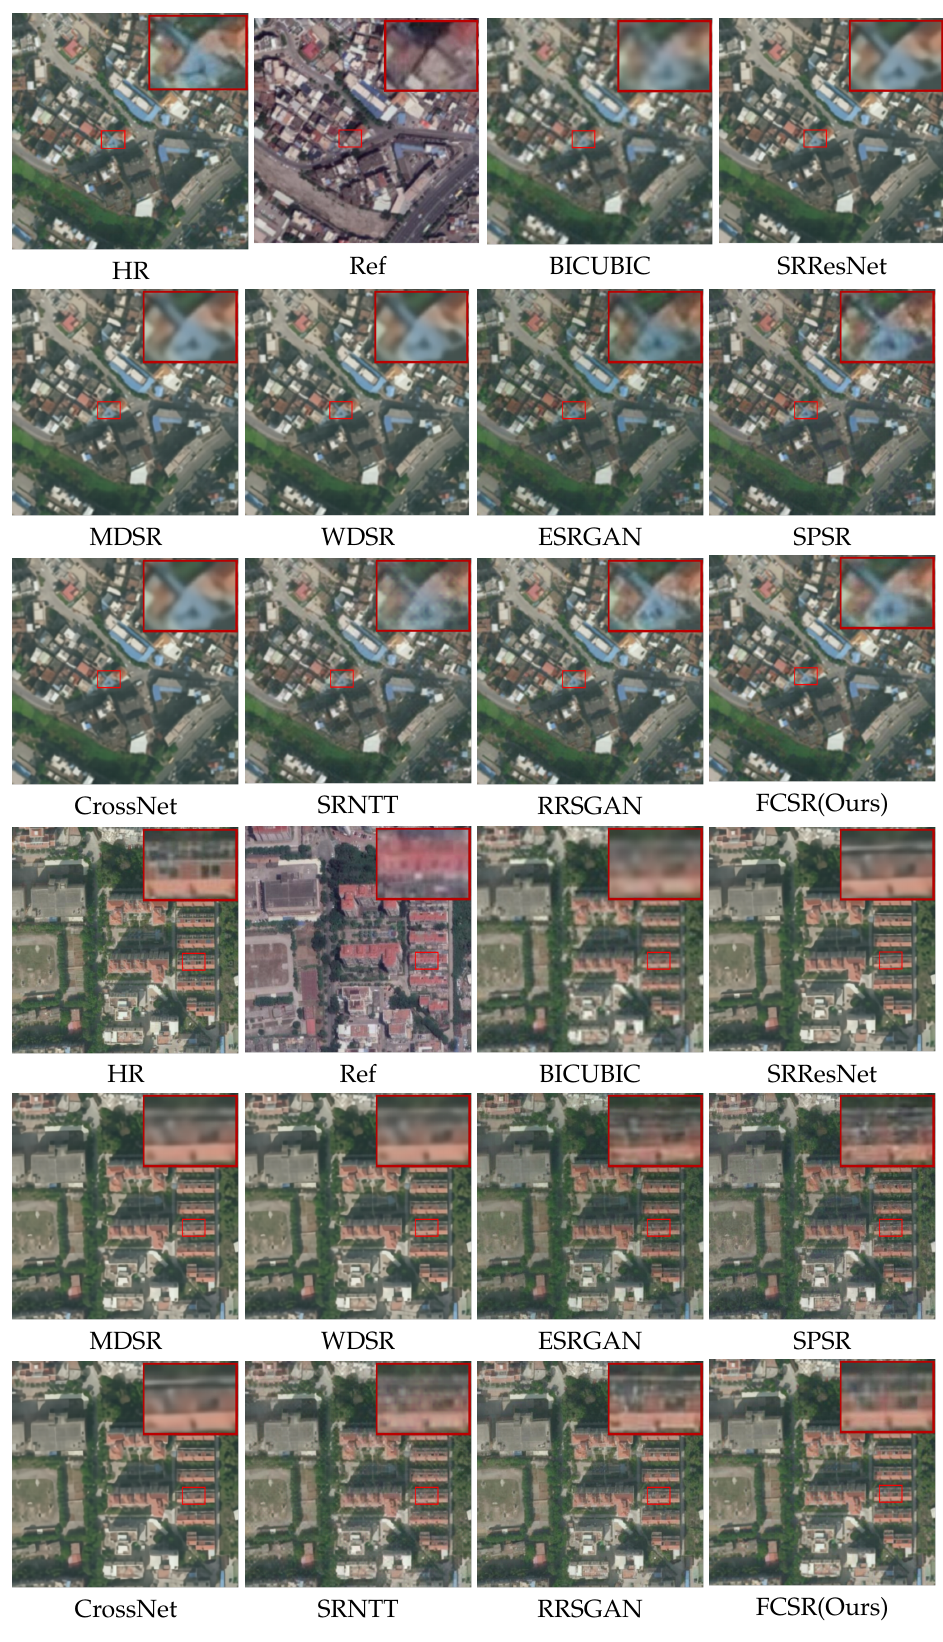
Figure 5. Visual comparison of some typical SR methods and our model of ×4 factor on the first test set. The results of comparison methods originate from [30]. We enlarge the image details inside the light red rectangle and show in the red rectangle in the upper right